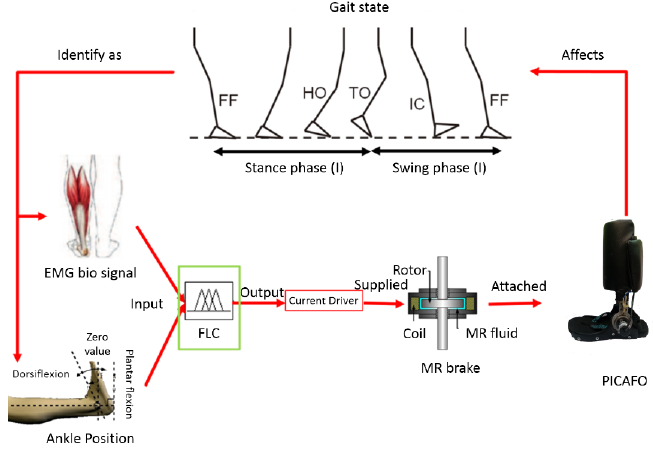
Figure 1. An overview process on the development of AFO as conducted in [9]. FF: Foot Flat; HO: Heel Off; TO: Toe Off; IC: Initial Contact; PICAFO: Passive Controlled Ankle Foot Orthoses; FLC: Fuzzy Logic Controller; MR: